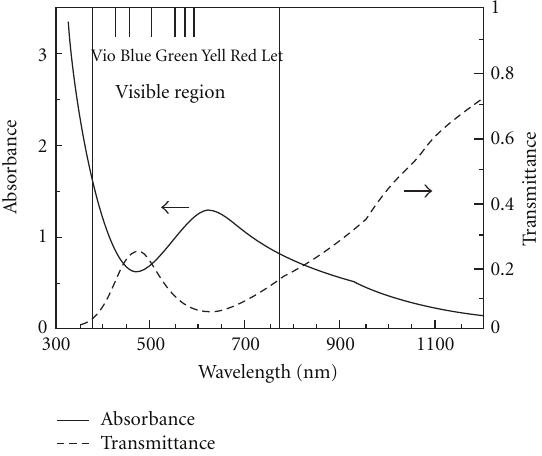
Figure 1: Optical absorption spectrum of blue topaz.